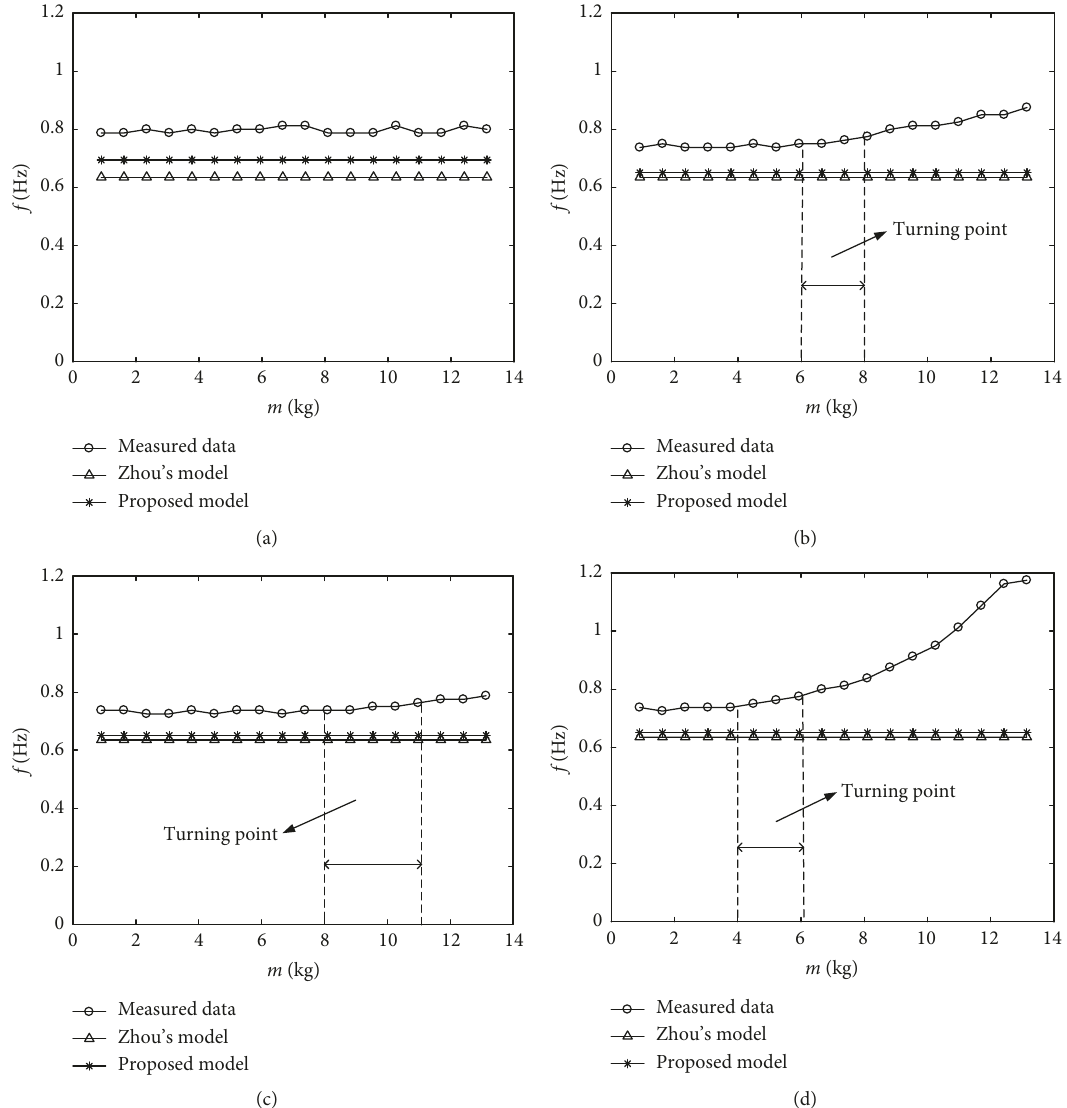
Figure 6: Measured and theoretical results using different materials for the lower and upper bowls: (a) K20H hard alloy, (b) 45# steel, (c) 6061 aluminum alloy, and (d) AZ91 magnesium aluminum